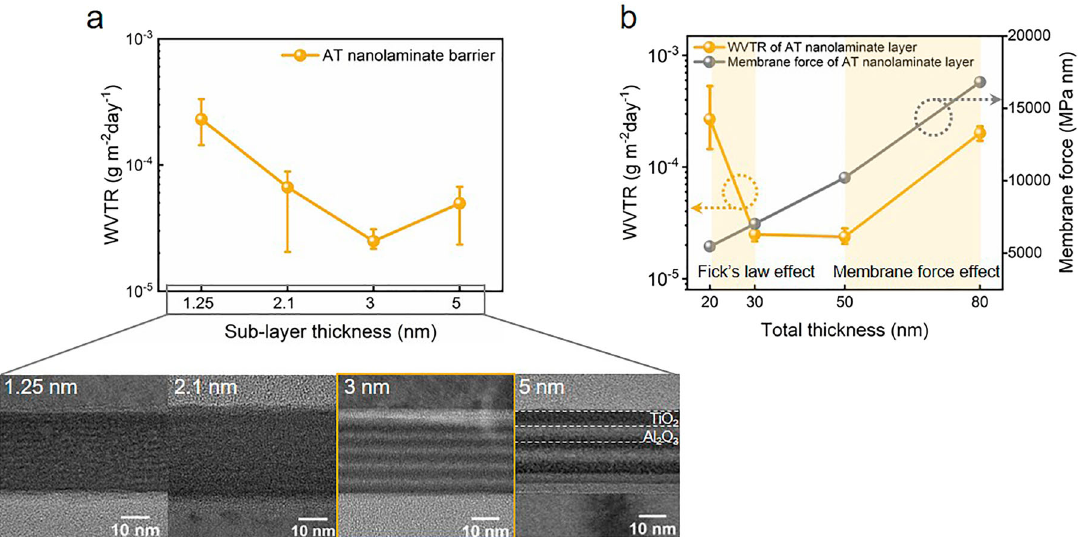
Fig. 3 Optimization of the encapsulation barrier structure. a TEM images and WVTRs of the Al 2 O 3 /TiO 2 nanolaminate layer (AT nanolaminate layer) with sub-layer thicknesses of 1.25, 2.1, 3, and 5 nm, respectively. Scale bar, 10 nm. b WVTR and membrane force of the AT nanolaminate barrier as a function of the total barrier thickness (with error bars that indicate standard